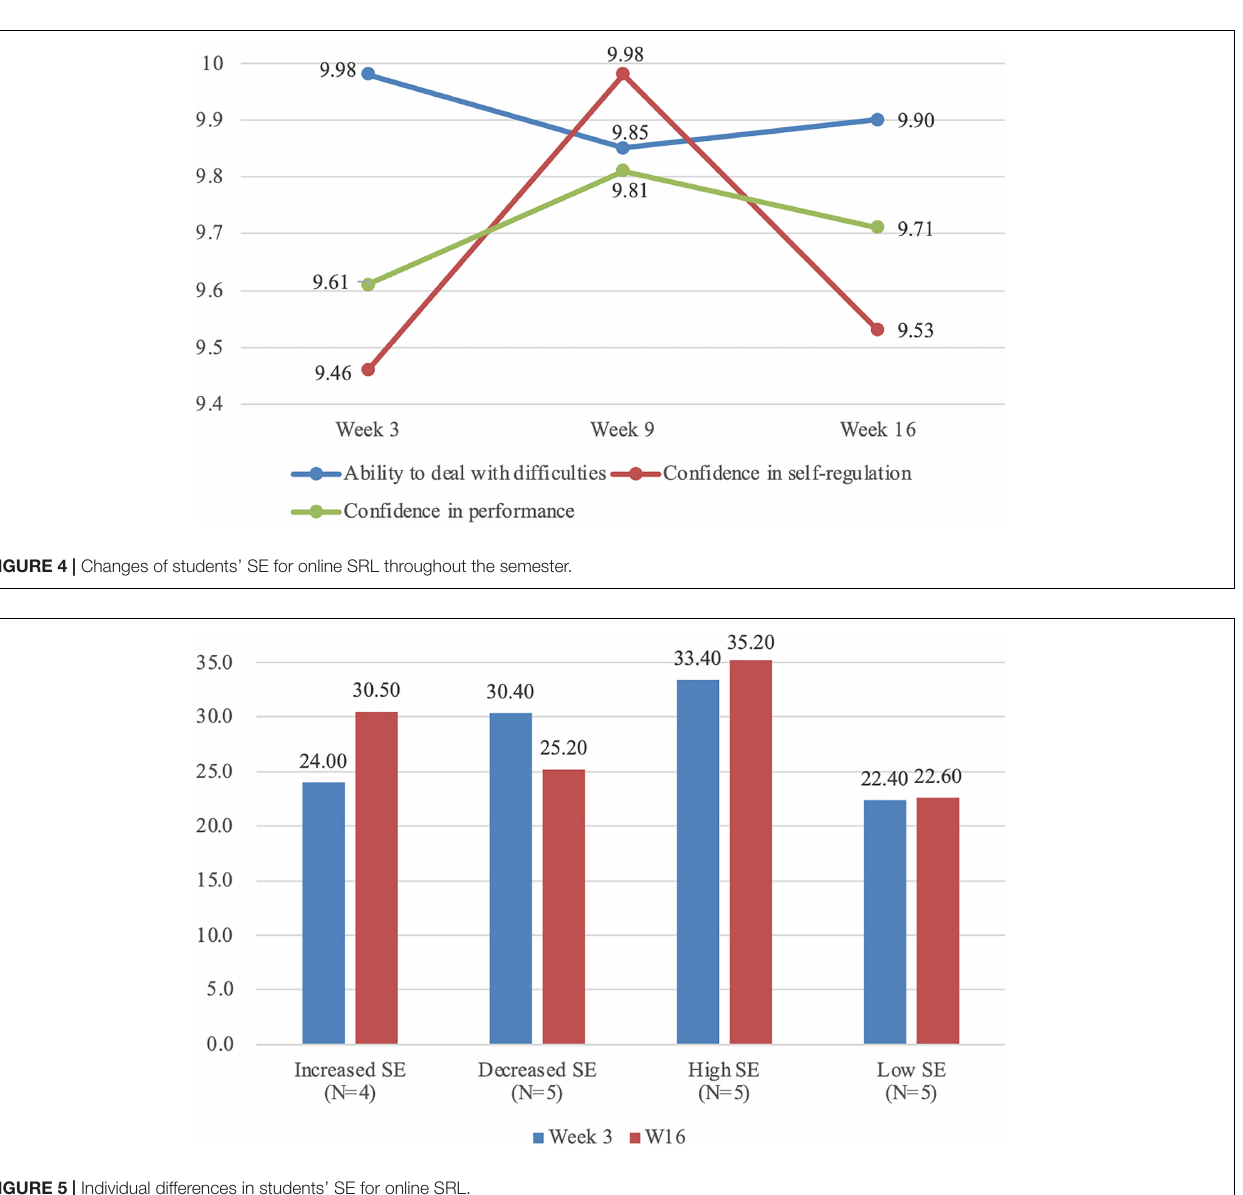
FIGURE 5 | Individual differences in students’ SE for online